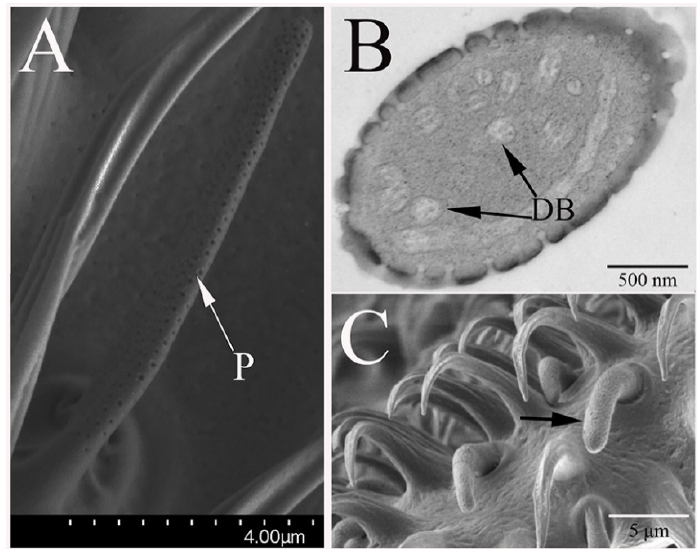
Figure 4. Sensilla basiconica subtype II on B. dorsalis antennae (AnSB-II): ( A ) the morphology of AnSB-II with conspicuous pores on male antennae. It is much thinner than AnSB-I. ( B ) Various dendritic branches are embedded in the AnSB-II lumen. The dendrite has a lamellar and a circular structure. ( C ) Sensilla basiconica on male maxillary palp (MaSB, black arrow marked). No morphology difference is found between the male and the female.